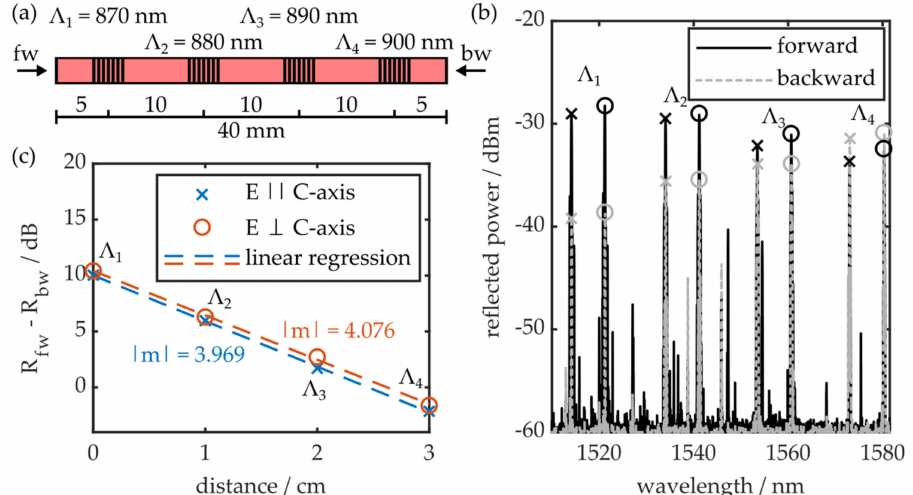
Figure 7. ( a ) Schematic of Bragg grating positions within the S-PCWG. ( b ) Bragg reflection signal of both coupling directions. ( c ) Forward and backward coupling peak power ratio as a function of Bragg grating